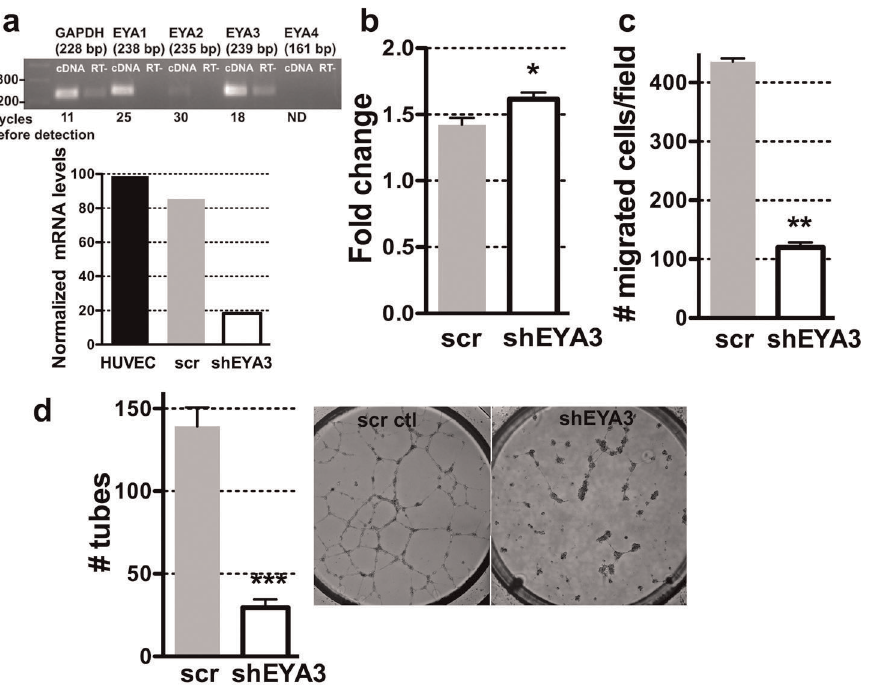
Figure 1. EYA3 knockdown in HUVECs attenuates single cell motility and capillary morphogenesis. ( a ) Expression of Eya transcripts in HUVECs. Real-time PCR product was analyzed at saturation (cycle 45) on a 1.5% agarose gel to confirm that amplified products were of the expected sizes. Indicated are the numbers of amplification cycles after which each signal was detectable; EYA4 was not detected (ND) after 45 cycles of amplification. RT- stands for cDNA from a reaction without reverse transcriptase. Graph below show the results of quantitative RT-PCR on HUVECs transduced with lentivirus scramble control RNA or shEYA3. ( b ) Change in cell density of HUVECs-scramble control and HUVEC-shEYA3 after 24 hours shows a small but significant increase when EYA3 levels are reduced. ( c ) Transwell migration of HUVEC-scramble control and HUVEC-shEYA3 shows a significant reduction in motility when EYA3 levels are reduced. ( d ) Capillary morphogenesis on matrigel was assayed using HUVEC-scramble control and HUVEC-shEYA3. A significant reduction in tube formation was seen when EYA3 levels were lowered. In each case the bars represent the mean and standard error of three experiments. The p -values were calculated by one-way ANOVA followed by a Tukey post test. ns is not significant, * p , 0.05, ** p , 0.01, *** p , 0.001. In each case the p value shown is relative to the